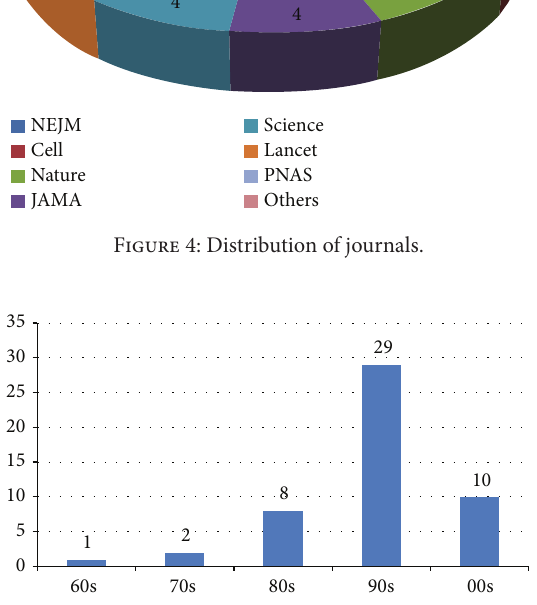
Figure 5: Number of papers published in each decade.